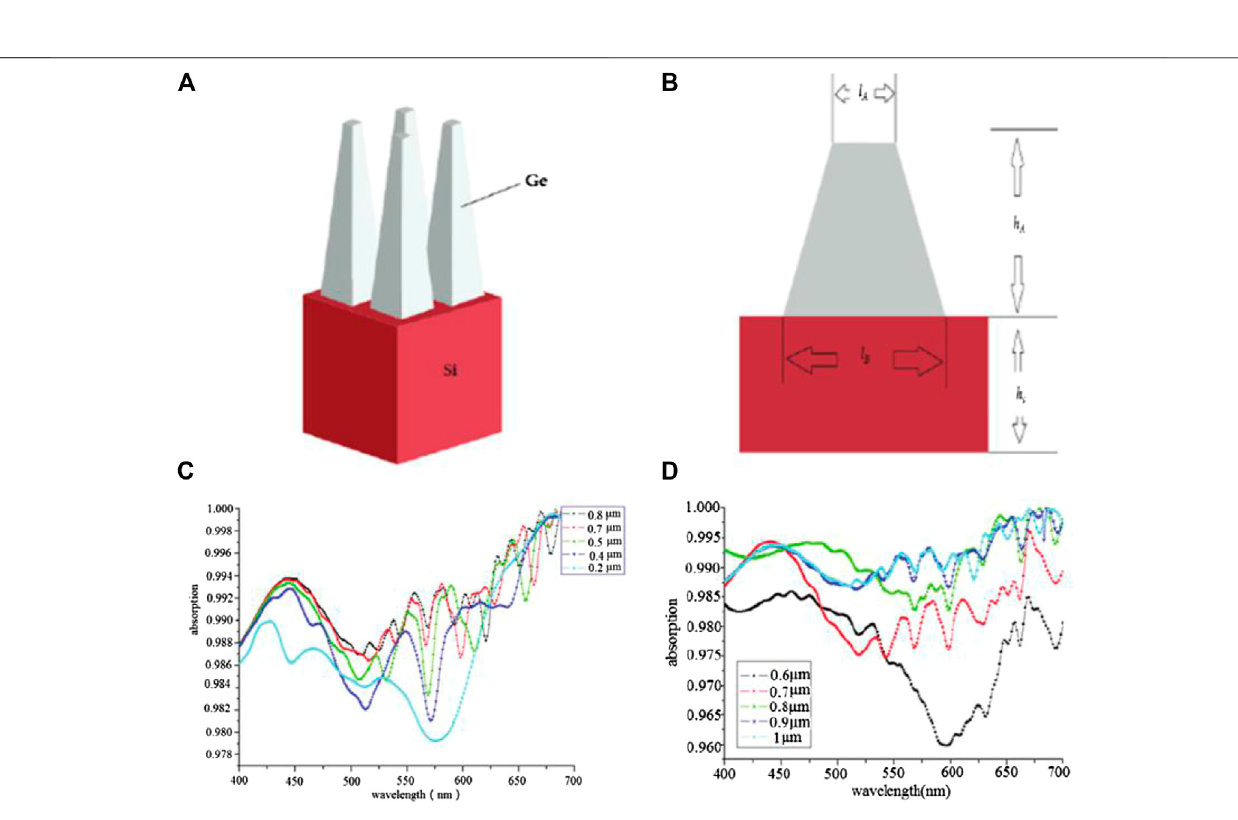
Frontiers in Physics |